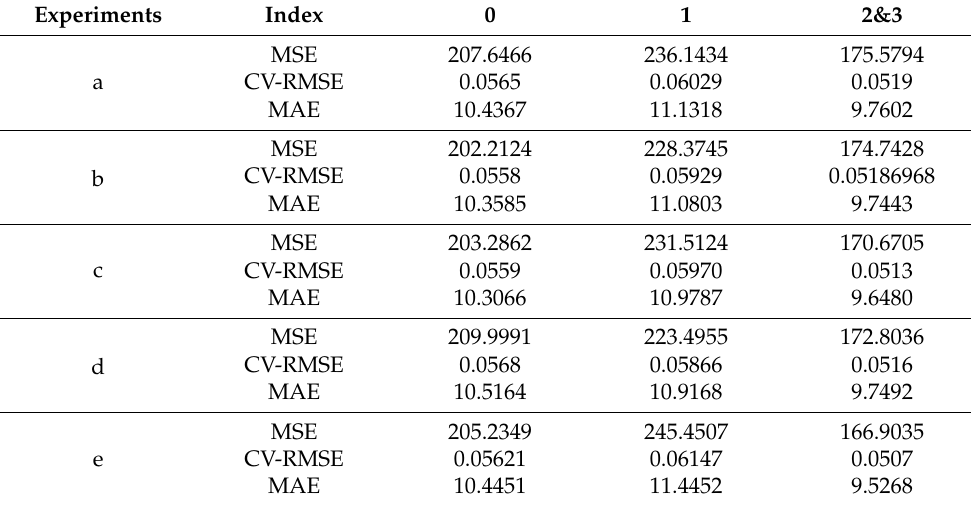
Table 4. Different model prediction results for another building.